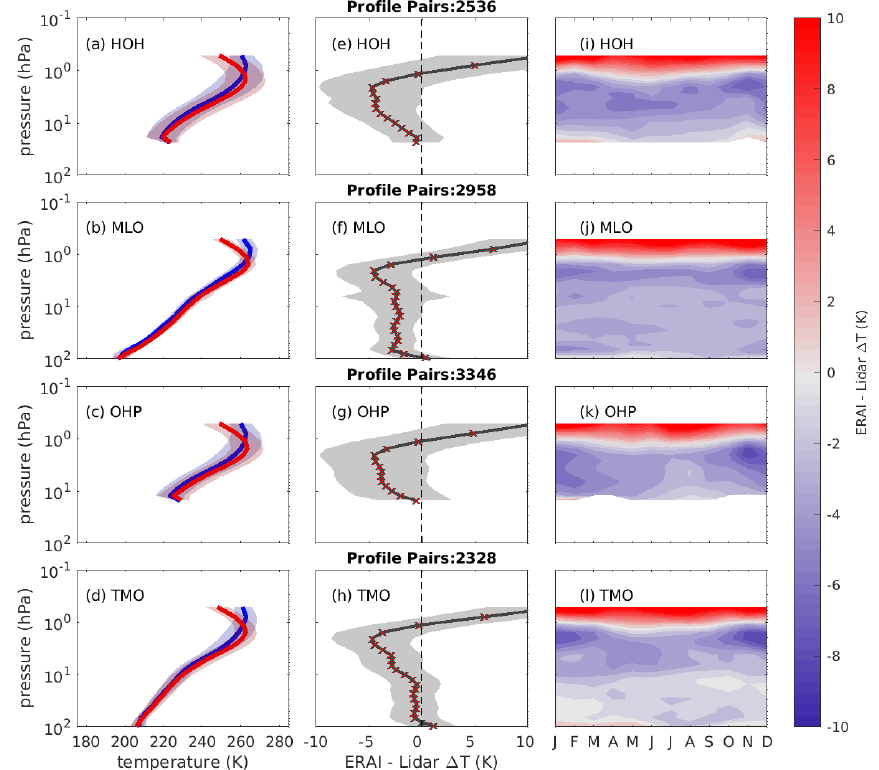
Figure 2. Mean profiles of matched temperatures from ERA-Interim (blue) and Rayleigh temperature lidar (red) positioned at (a) Hohen- peissenberg, (b) Mauna Loa, (c) Observatoire de Haute-Provence and (d) Table Mountain Observatory between 1990 and 2017. Shading depicts 1 standard deviation in the mean temperature. The vertical profiles of the mean of the differences between ERA-Interim and each lidar shown in (a–d) are shown in (e–h) respectively; shading shows 1 standard deviation of mean difference. Crosses are red where the mean of the differences were different from zero at the 95% significance level. Panels (i–l) show the temperature differences as a function of month and pressure level for each of the lidars shown in panels (a–d)